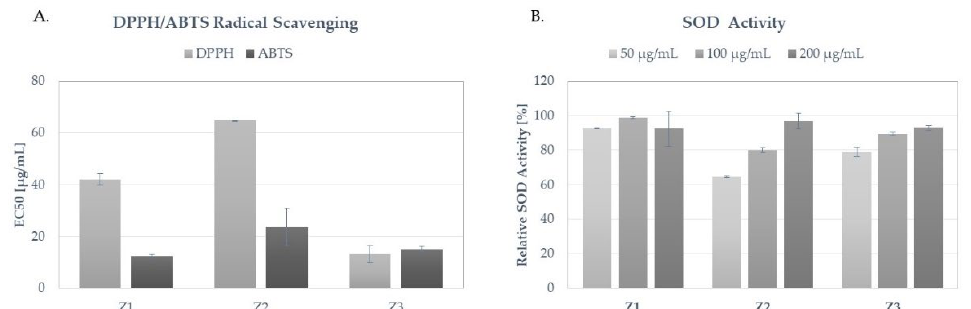
Figure 4. Antioxidant activity of Z1, Z2 and Z3 extracts from Z. bungeana : ( A ) neutralization of DPPH and ABTS free radicals, displayed as EC 50 ; ( B ) relative activity of superoxide dismutase (SOD) of Z1, Z2 and Z3 extracts; histograms show mean values ±SD, n =